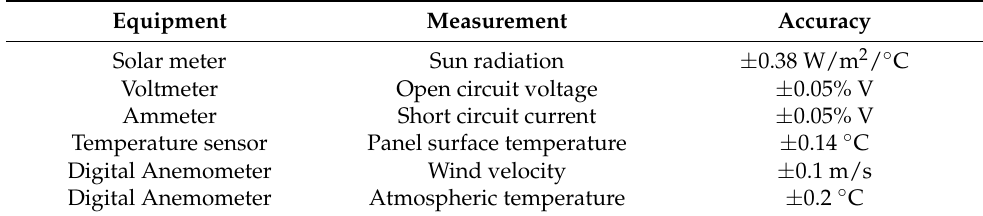
Table 2. List of the used equipment and their accuracy